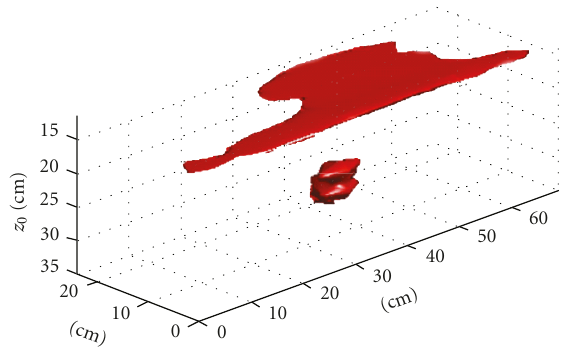
Figure 6: 3D reconstruction of a plastic antipersonnel mine obtained by applying the two-step migration algorithm to real laboratory data. The mine is buried 10 cm below the surface of a sand box. The frequency range is from 2 to 6GHz; the TX-RX distance is 14 cm; the antenna is moved 13 cm above the soil. The 3D reconstruction is a 3D contour of a selected amplitude of the migrated signal that emphasizes the energy reflected by the sand surface and the energy scattered by the